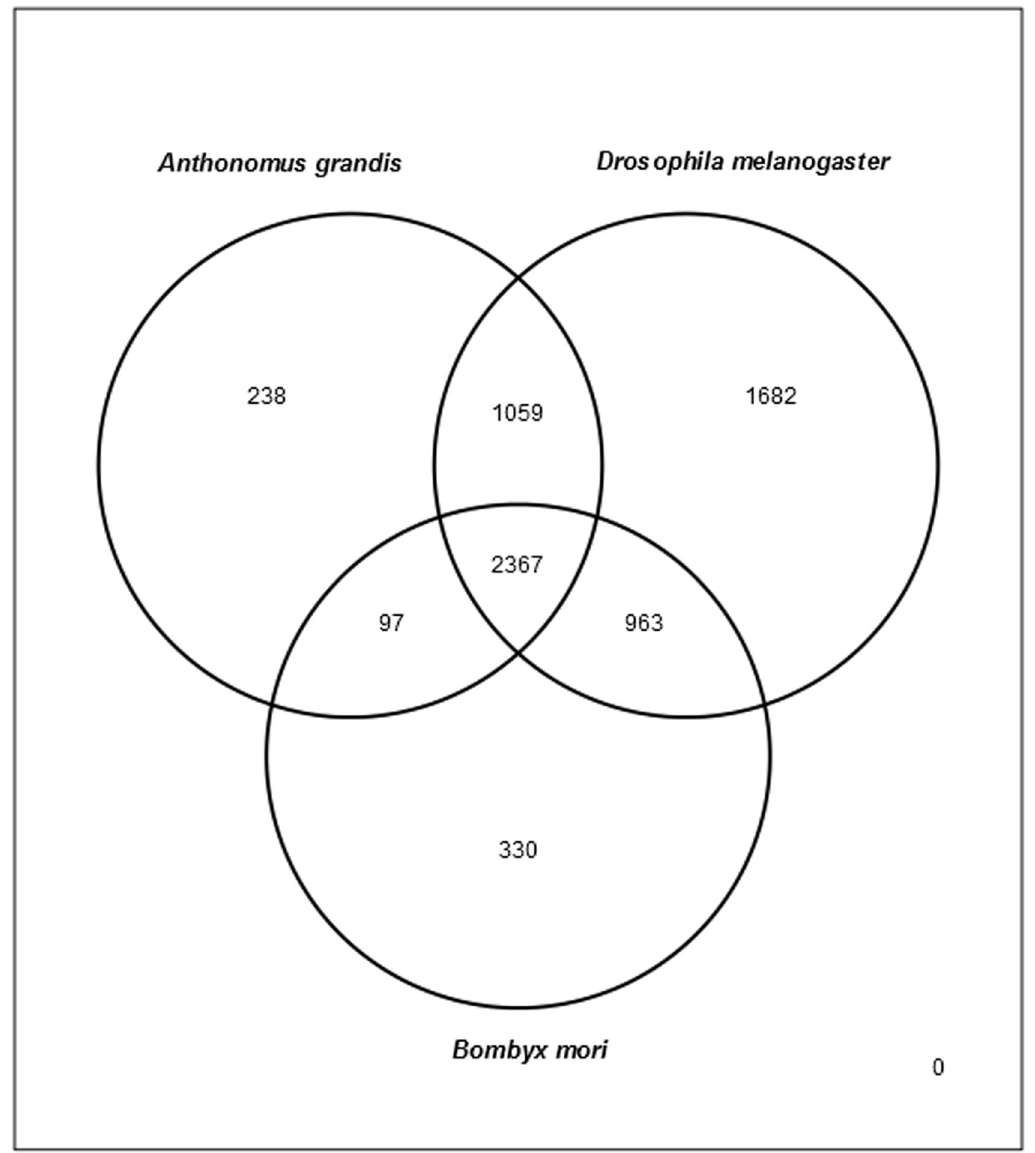
Figure 4. Venn diagram of the number of contigs from A. grandis which show IPR matches to D. melanogaster and/or B. mori . Numbers are unique Butterflybase and Flybase IPR results. The number of similar protein families between A.grandis and D. melanogaster is higher than A.grandis and B. mori